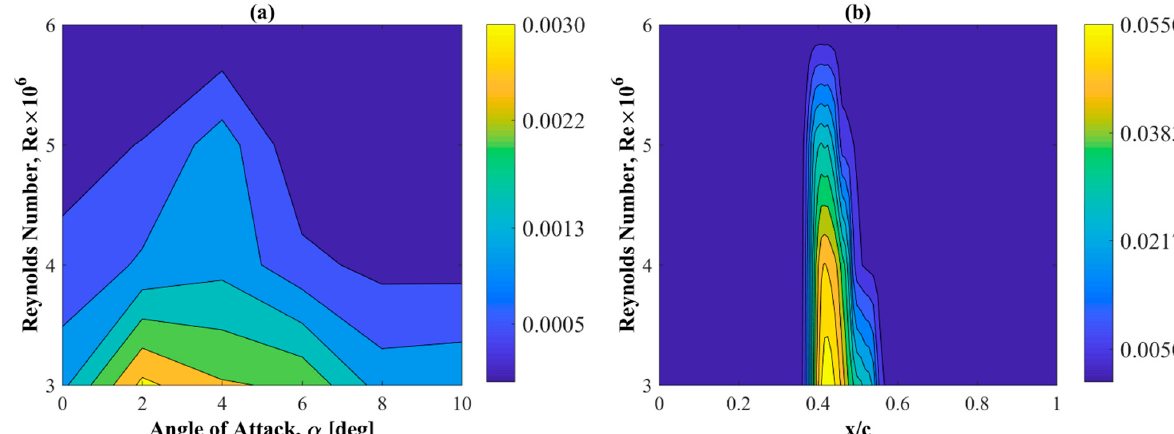
Figure 11. Standard deviation of the static pressure coefficient for the suction side of the airfoil and for the angle of attack of 4 degrees: ( a ) as a function of the angle of attack and Reynolds number; ( b ) as a function of x/c and Reynolds number.